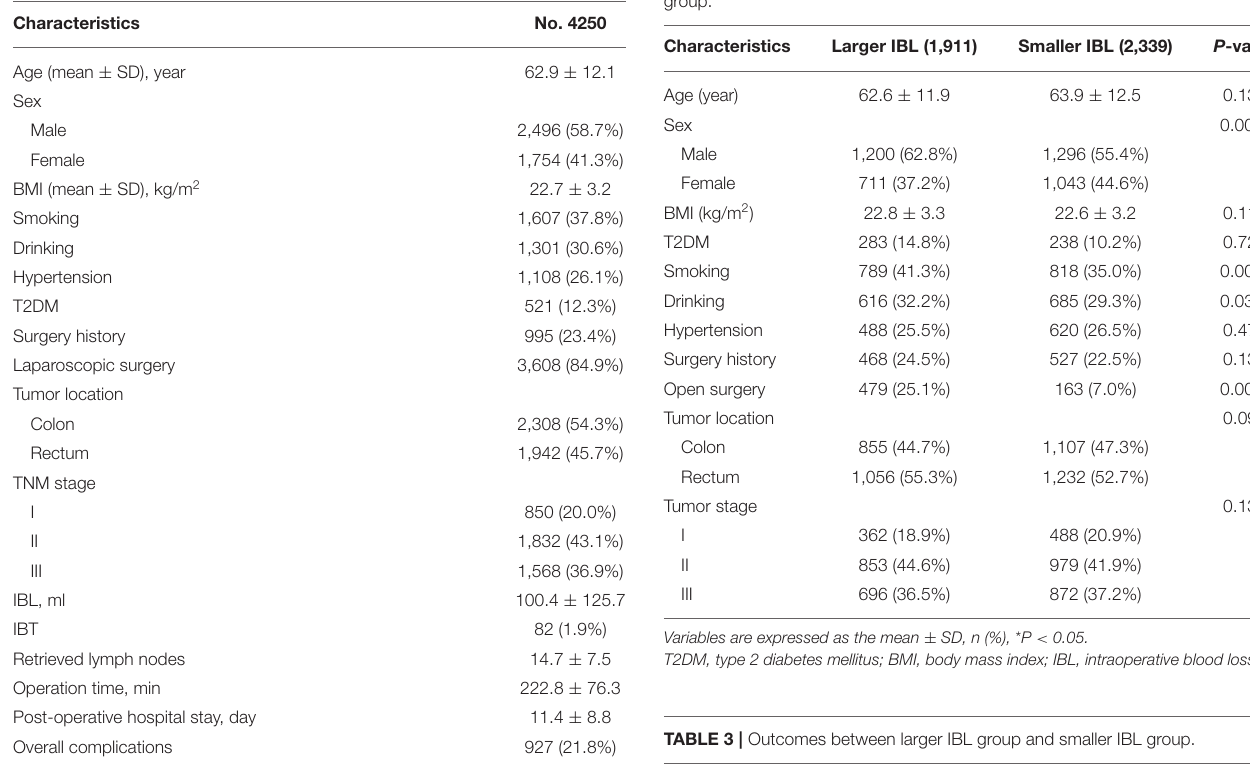
TABLE 1 | Clinical characteristics of CRC patients. TABLE 2 | Baseline characteristics of between larger IBL group and smaller IBL